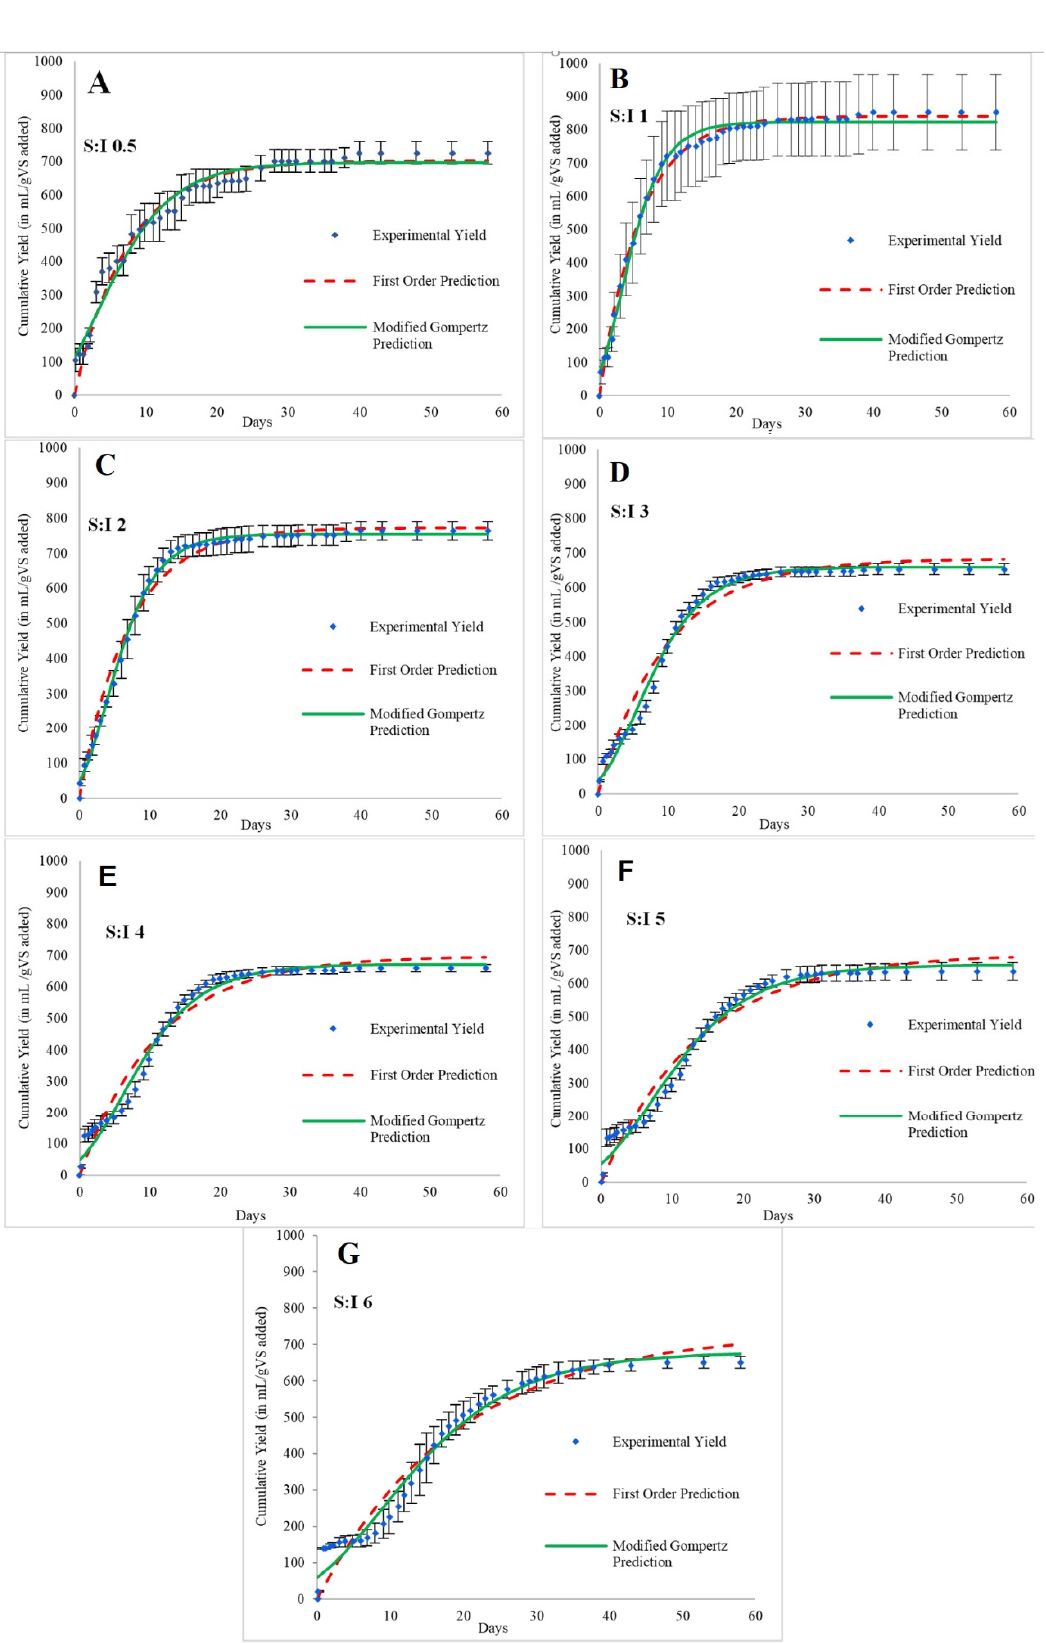
Figure 2. Observed and predicted biogas (scrubbed) yields at S:I ratios ( A ) 0.5, ( B ) 1, ( C ) 2, ( D ) 3, ( E ) 4, ( F ) 5 and ( G ) 6, using the first-order kinetic and the modified Gompertz model.